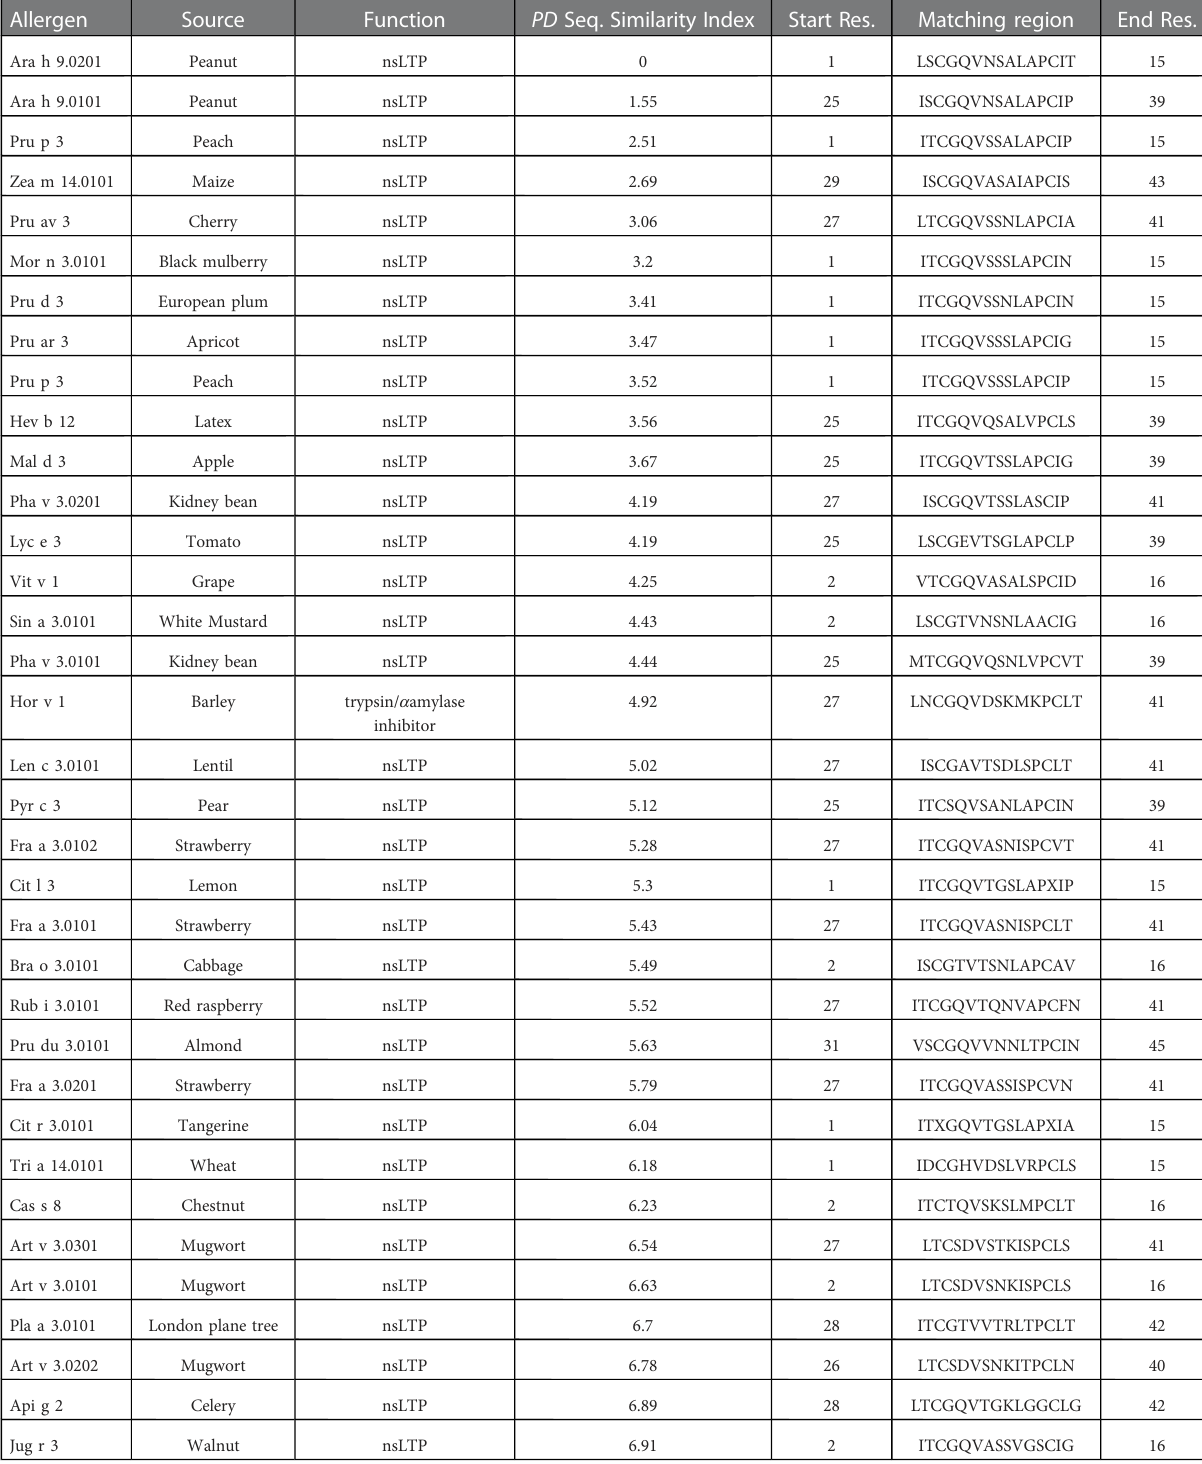
TABLE 6 SDAP analyses for Ara h 9 peptide 1_ LSCGQVNSALAPCIT.